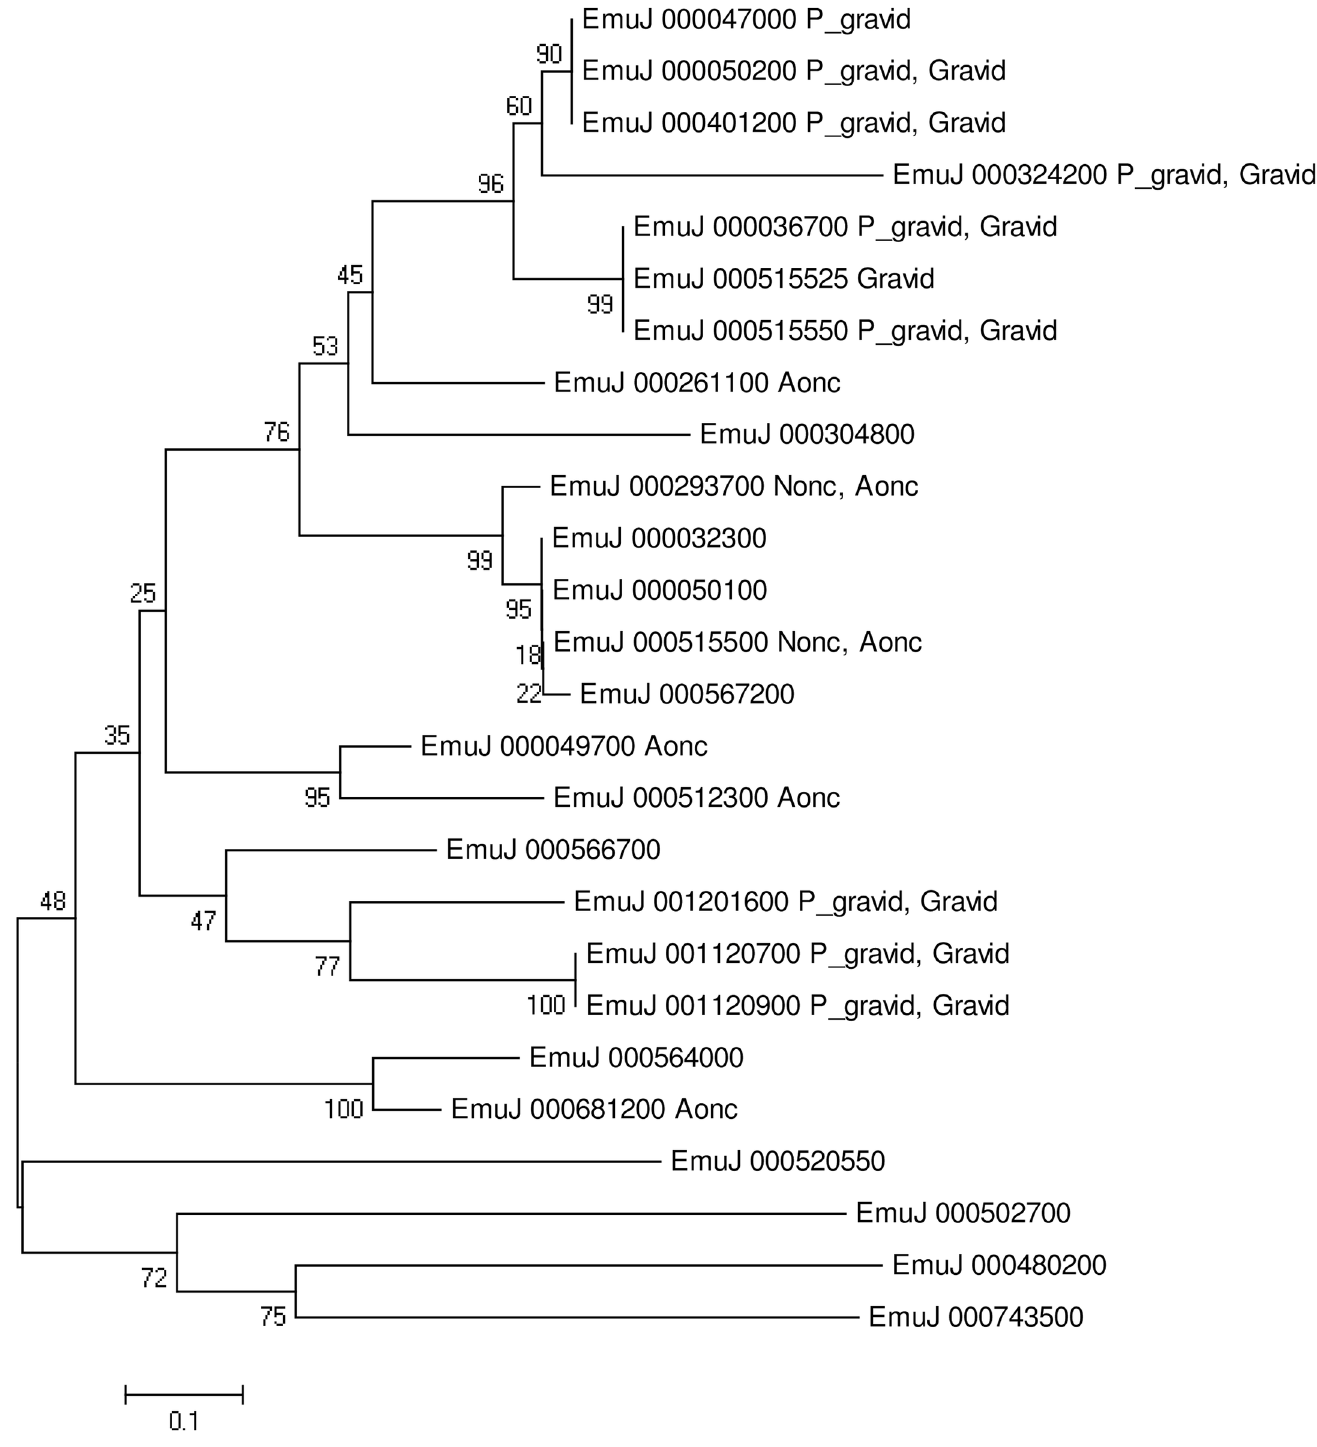
Fig 5. Phylogenetic analyses of diagnostic antigen gp50 amino acid sequences. The neighbor-joining tree was constructed by MEGA 6.0 (www. megasoftware.net); bootstrap values were obtained from 1,000 replicates. Nonc: RPKM > 100 at stages of non-activated oncosphere; Aonc: RPKM > 100 at stages of activated oncosphere; P_gravid: FPKM > 100 at stage of pre-gravid [23]; Gravid: FPKM > 100 at stage of gravid